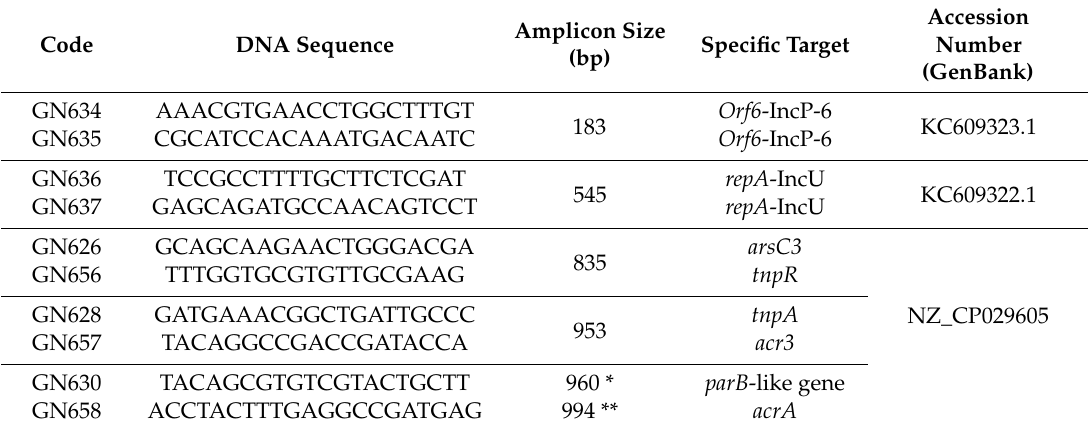
Table 2. List of primers used in this